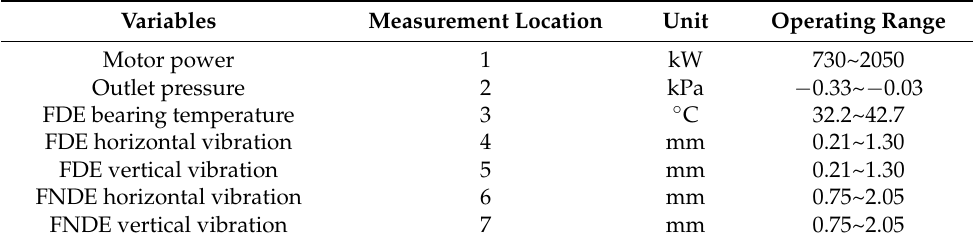
Figure 3. Measurement locations of the parameters of the ID fan. Table 1. Normal operating range of parameters related to the ID fan.